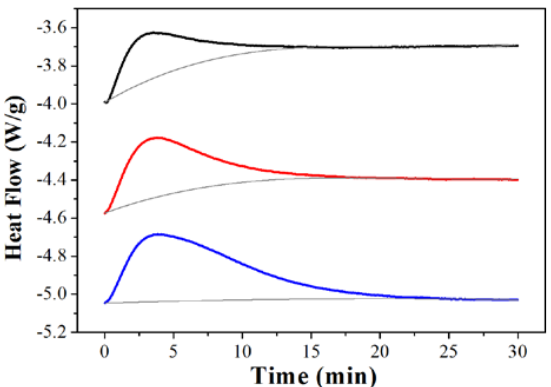
Figure 2. Plot of heat of flow for the adsorption of CO 2 on NSPC as a function of time using pure CO 2 at 1 atm at the temperatures of 24.5, 44.7, and 65.0 °C in blue, red, and black, respectively. The baselines in gray were used to integrate the curves and calculate the corresponding integrate molar heat of adsorption at each temperature. The corresponding CO 2 uptake curves are given in Figure 1.